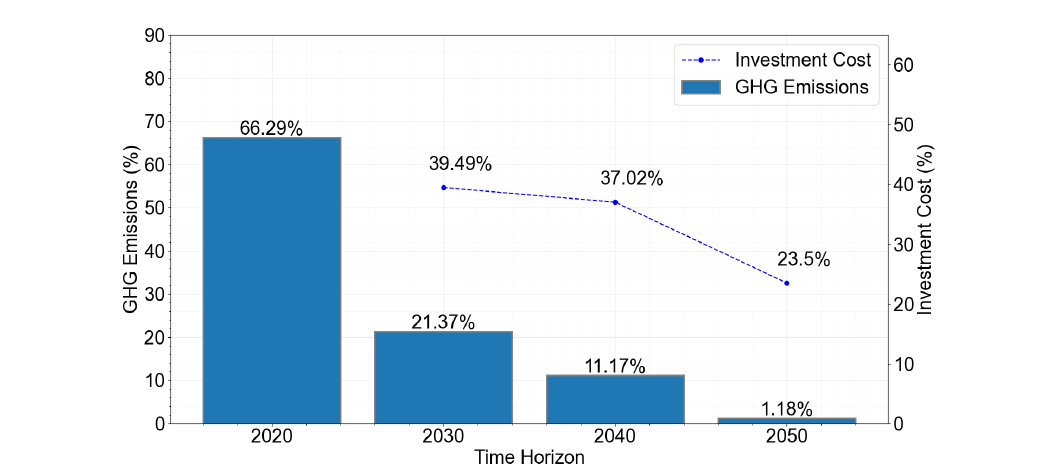
Figure 14. Alternative 4—Comparison between emissions and the investment cost for the residential sector.